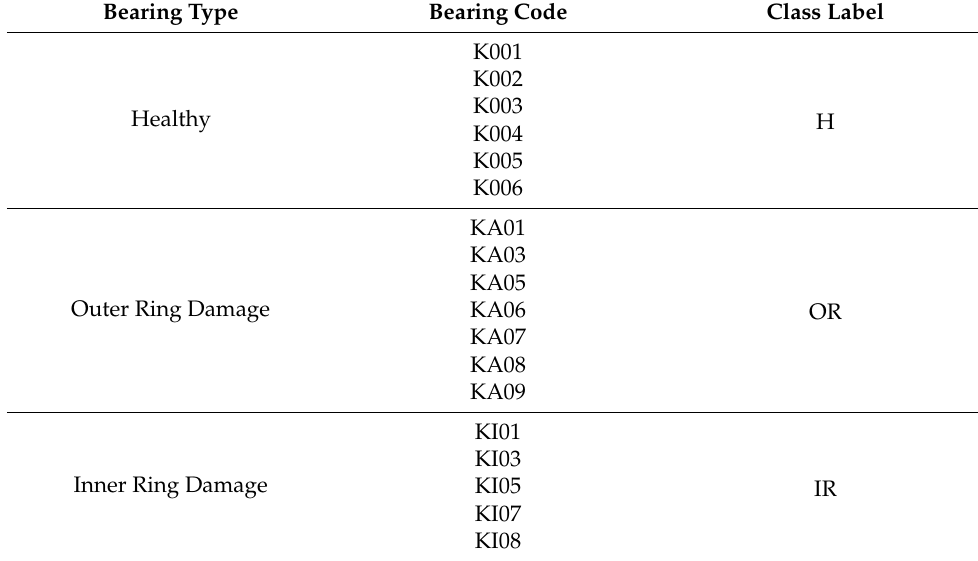
Table 2. Arrangement of the PU dataset with artificially induced